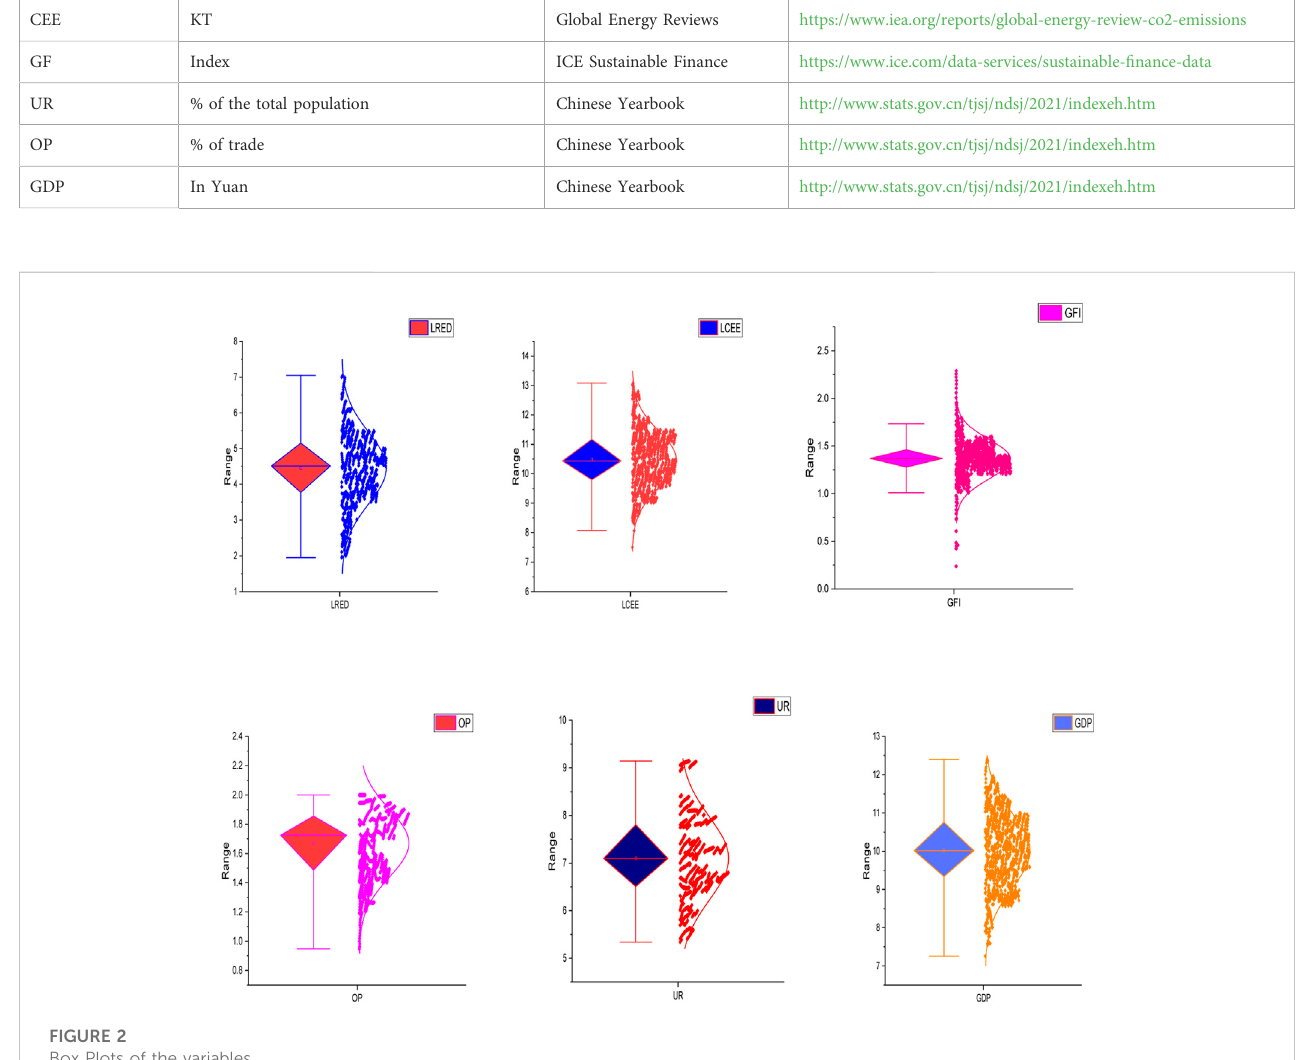
FIGURE 2 Box Plots of the